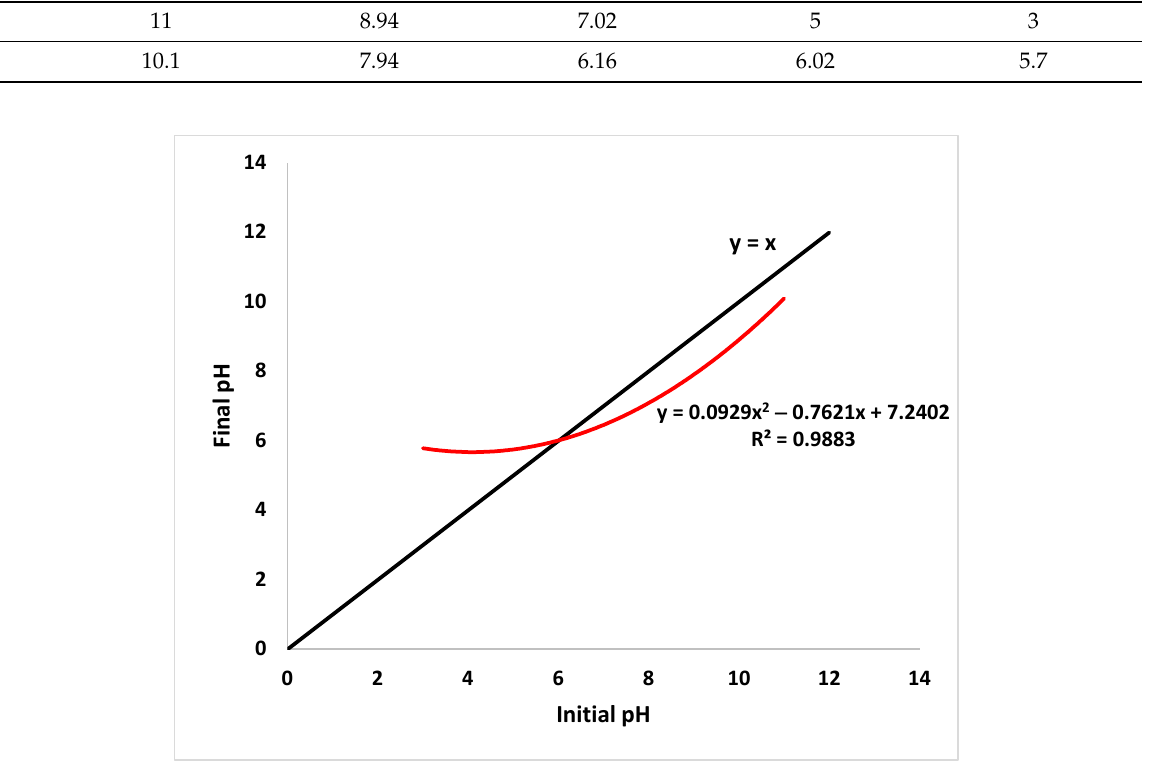
Figure 11. CuFe 2 O 4 /rGO/HNT point of zero charge (pH PZC